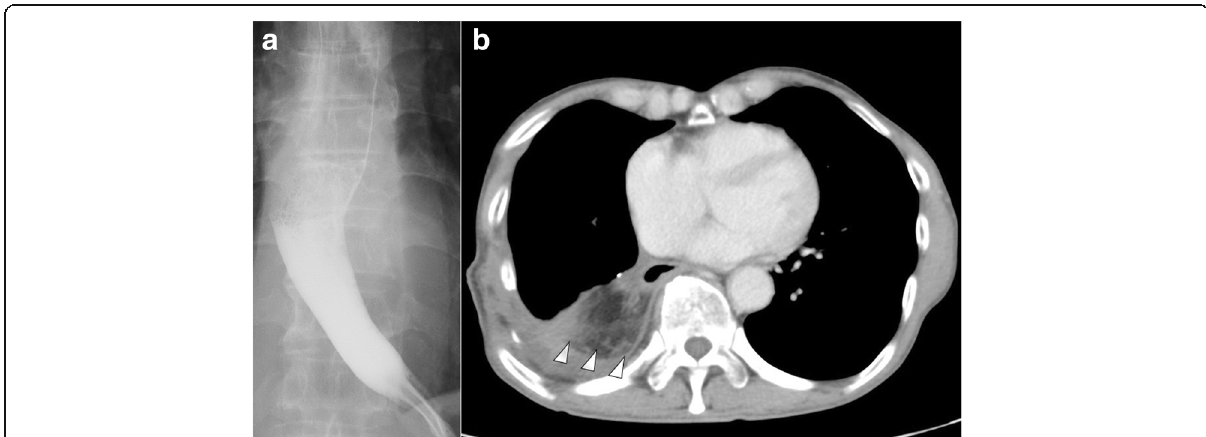
Fig. 4 Postoperative image findings. a An esophagogram obtained 7 weeks after the operation showed neither leakage of the contrast medium from the esophageal wall, nor stenosis of the esophagus. b Chest CT performed 5 months after omentopexy showing the omental pedicle flap filling the surplus pleural space in the right thoracic cavity (white